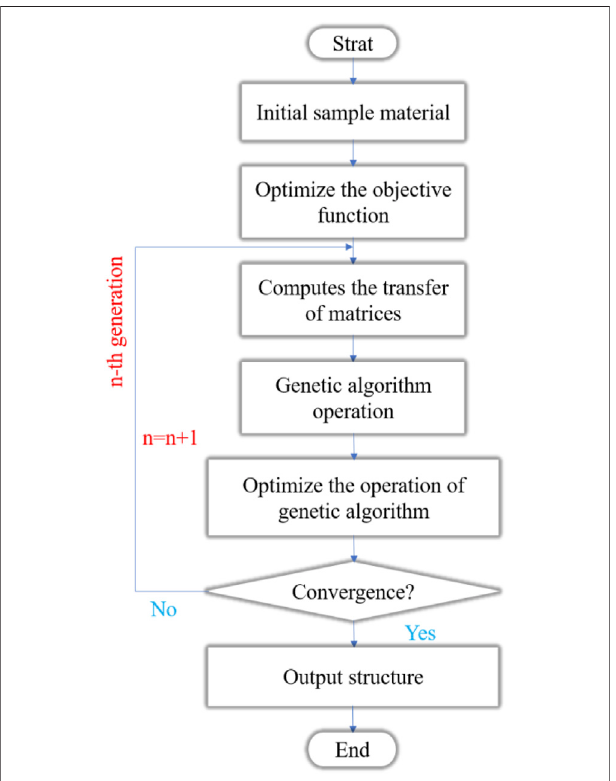
FIGURE 3 | Flow chart for obtaining the latest optimized membrane structure using genetic algorithm.